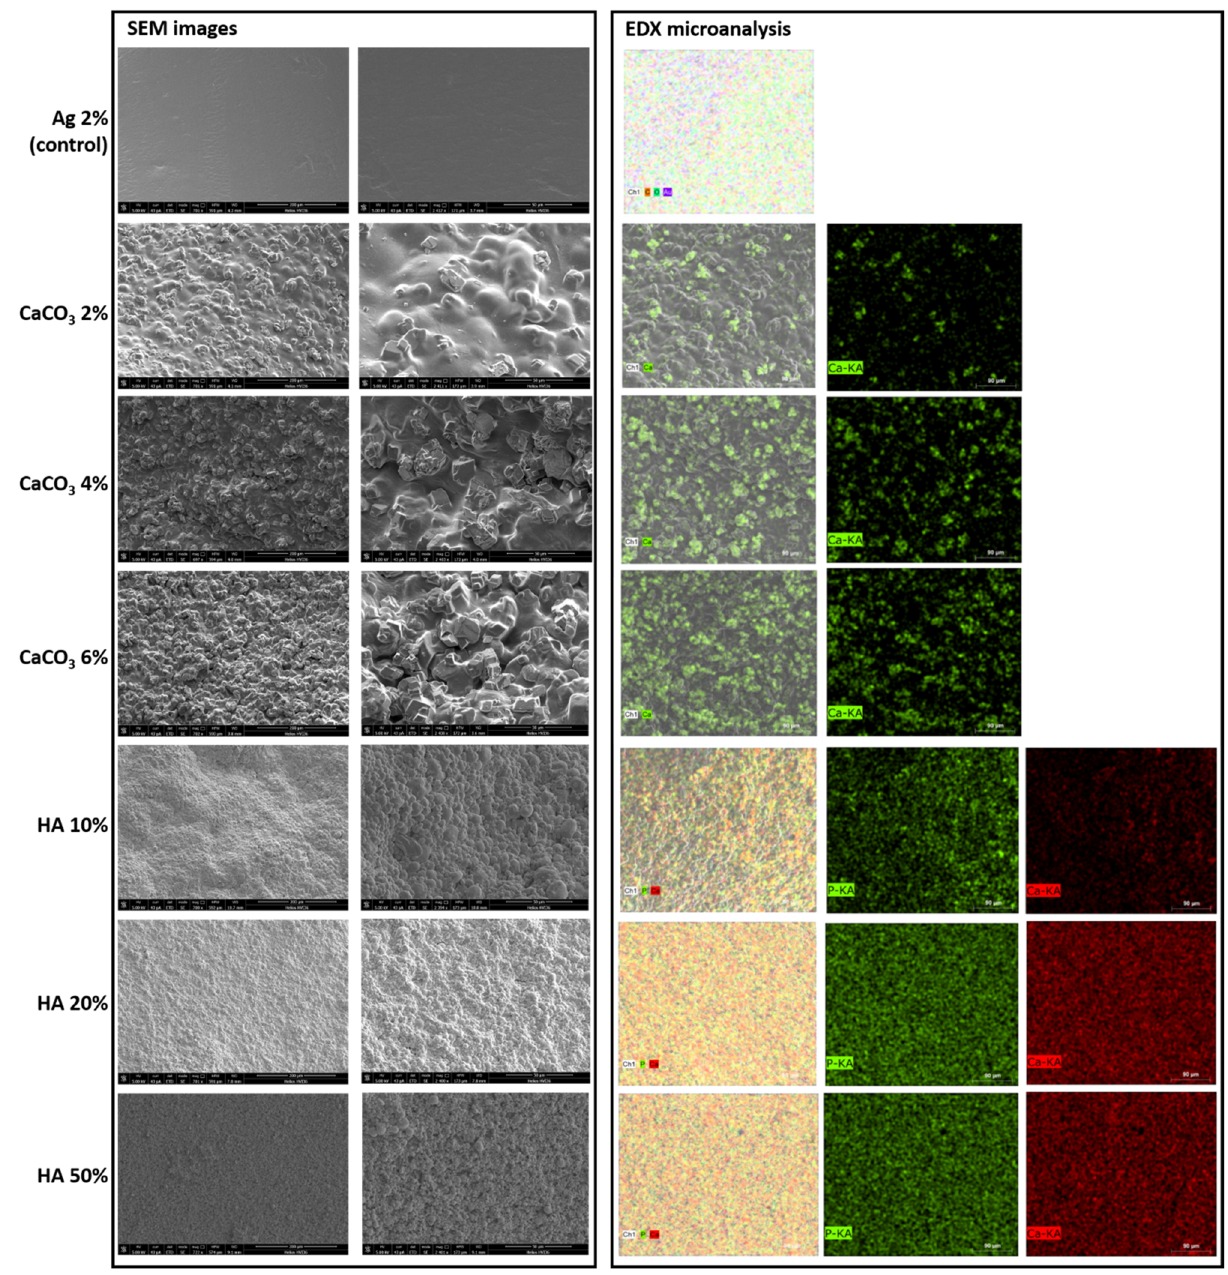
Figure 4. SEM images and EDX analysis for samples containing different concentrations of CaCO 3 and HA particles. SEM images (left panel) are reported at 700X (first column) and 2400X (second column) magnifications. EDX microanalysis (right panel) is reported at 700X magnification for agarose matrix (2% w/v) and for hydrogels doped with CaCO 3 and HA particles at different concentrations. For EDX microanalysis, the first image (Ag 2% w/v) reports the main elements automatically found by the system, merged with the SEM image channel; the other images show the single elements analyzed. For samples doped with CaCO 3 particles, Ca is reported in green. For samples doped with HA particles, P is reported in green and Ca is reported in red. In the agarose matrix without particles, no traces of Ca and P were found, but only C, O and peak at the second interface (peak2). peak1 showed an increasing trend concerning the concentration of parti- cles, thus showing a higher reflection in the case of higher concentrations. Conversely, peak2 decreased when the particle concentration increased. Indeed, as the concentration increases, less energy crosses the sample and thus, less energy is reflected back from the second interface. Thirdly, the SampEn parameter showed an increasing trend with respect to the content of particles, except for the control value (Ag 2%, which has no embedded parti- cles). The SampEn value for the control group was associated with the highest SampEn value, thus indicating the highest irregularity in the instantaneous phase signal of RF data from agarose samples not doped with particles.